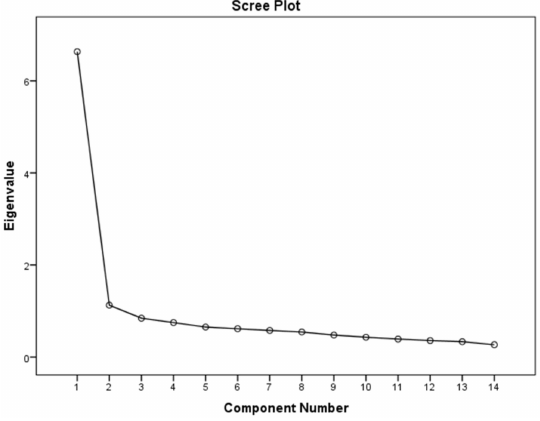
Figure 3. Scree Plot Graph for Main